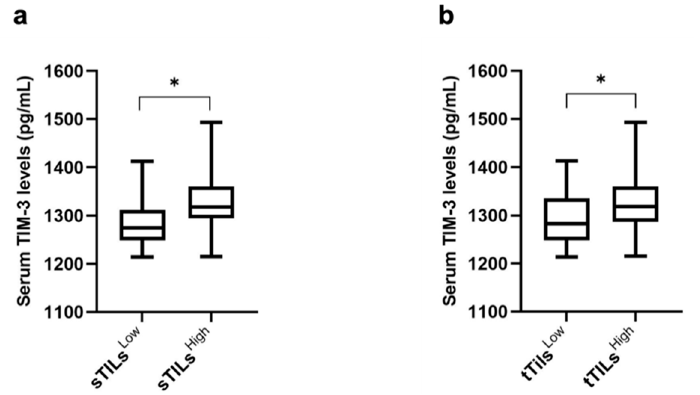
Figure 7. Box plot analysis of serum TIM-3 levels and their association with the TIM-3 expression in stromal and total TILs. ( a ) Serum TIM-3 levels and s TILs (sTILs Low , n = 22; sTILs High , n = 20). ( b ) Serum TIM-3 levels and t TILs (tTILs Low , n = 22; tTILs High , n = 23) (* p < 0.05).